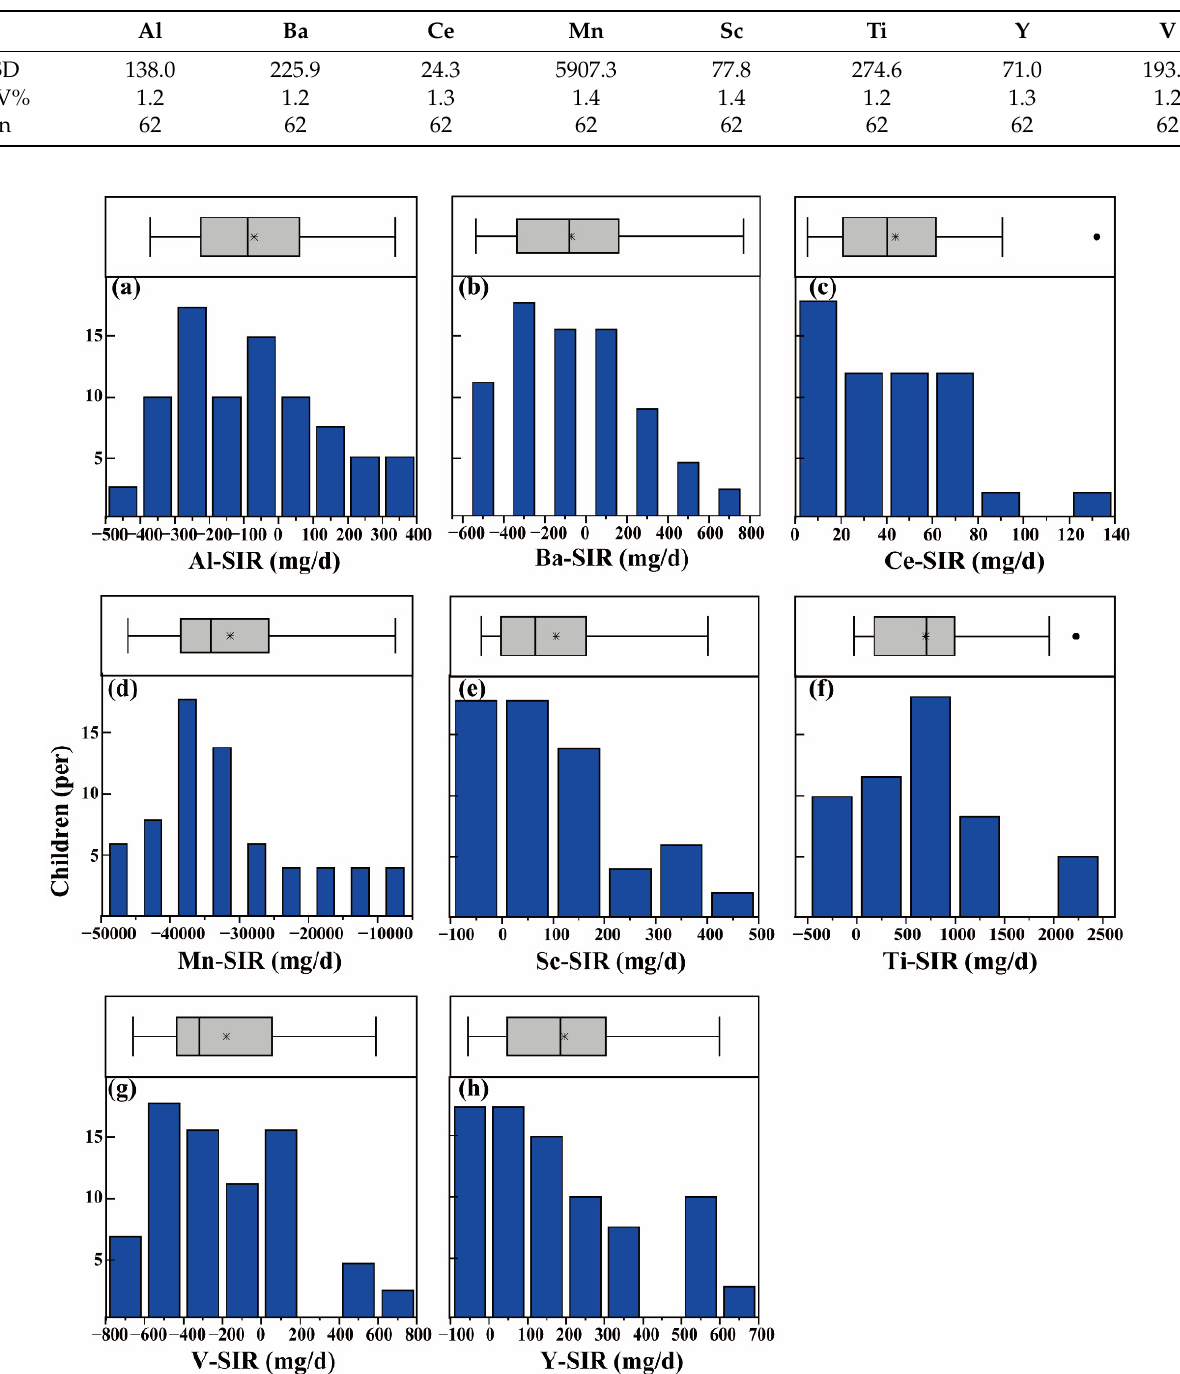
Figure 1. Frequency distribution histogram and outlier box of soil ingestion rate (SIR) based on tracer Al ( a ), Ba ( b ), Ce ( c ), Mn ( d ), Sc ( e ), Ti ( f ), V ( g ), and Y ( h ). The * represents mean values, and dot sign represents outliers.